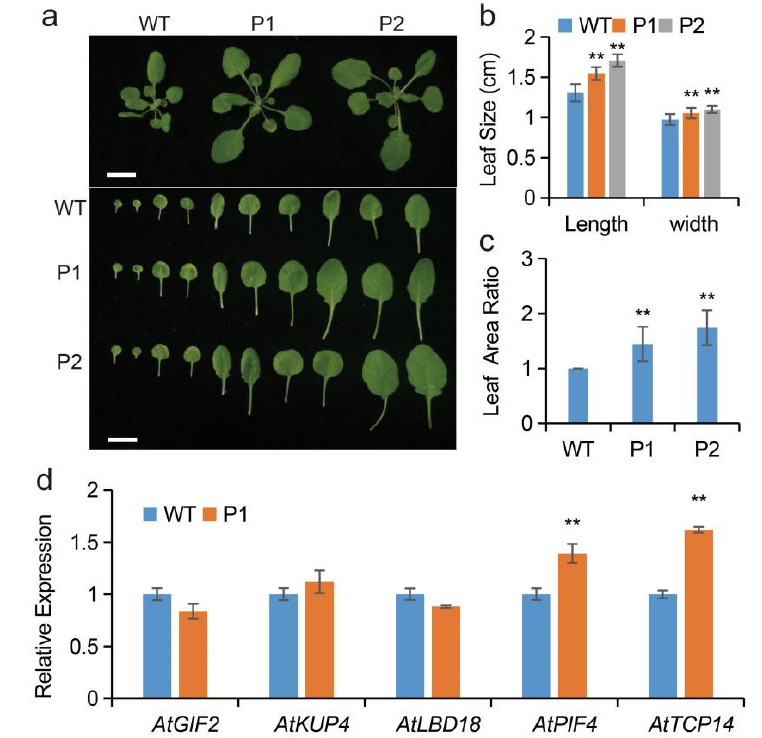
Figure 4. EuPIP1;1 promotes Arabidopsis growth. ( a ) Phenotypes of WT and transgenic lines (P1 and P2) grown in soil for 32 d. Bar = 1 cm. ( b ) The leaf size. ( c ) The leaf area ratio. ( d ) The expression level of growth-related genes in WT and P1. (** p < 0.01, one way ANOVA).